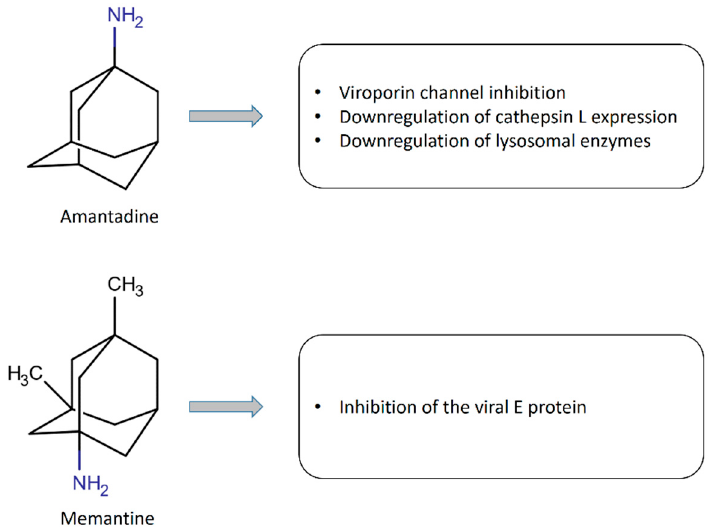
ff ects of amantadine and